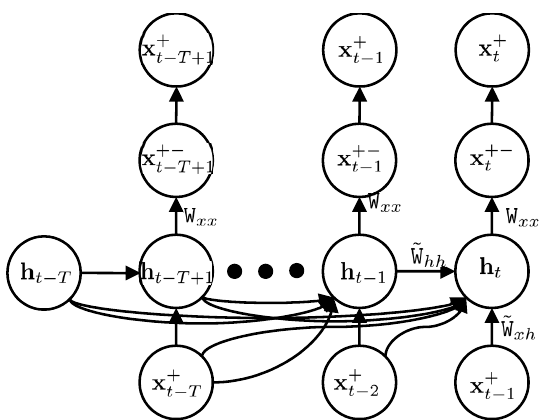
Figure 4. IMU error modelling reformulated as a time series prediction. The posterior estimation of the state vector is utilized in the target node ( top layer ), the output of our model is considered as the output node ( second layer ), the previous state vectors are in the input layer ( bottom layer ) and the latent vectors are in the hidden layer ( third layer ).